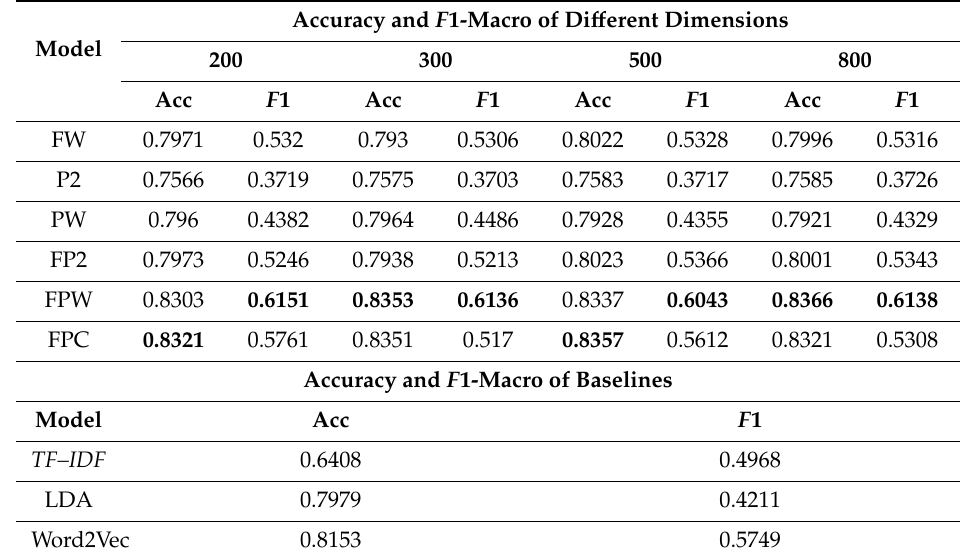
Table 7. Results of FudanNLP in 17 classes for 4117 texts by KNN.